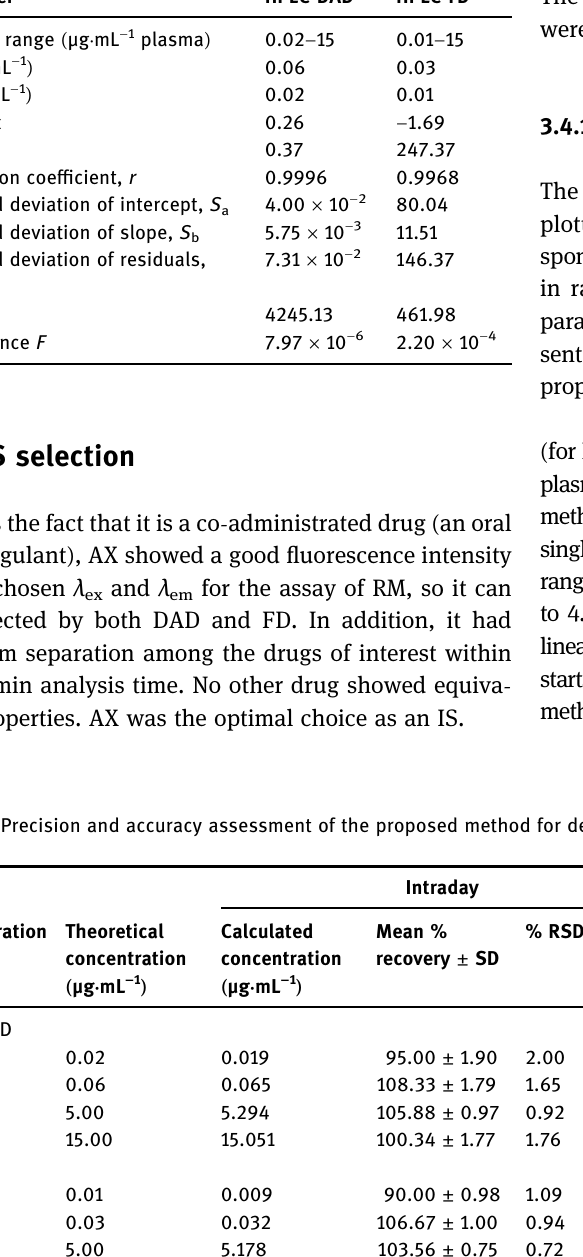
Table 2: Parameters of regression for RM determination in plasma Parameter